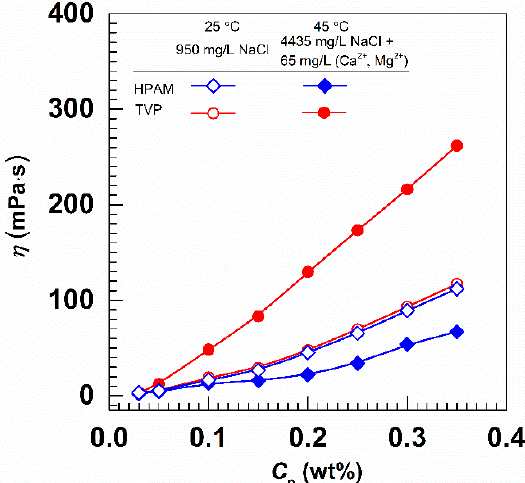
Figure 1. Concentration dependence of TVP versus HPAM at simulated surface (25 ° C, 950 mg/L NaCl) and oil reservoir conditions of Daqing Reserve III (45 ° C, 4435 mg/L NaCl + 65 mg/L Ca 2+ + Mg 2+ ). Shear rate, 7.34 s − 1 .